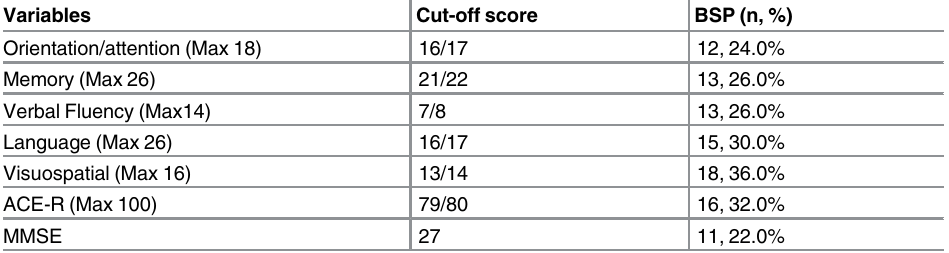
Table 4. Cognitive impairments in BSP patients without oral pharmacological medications (%) (n =